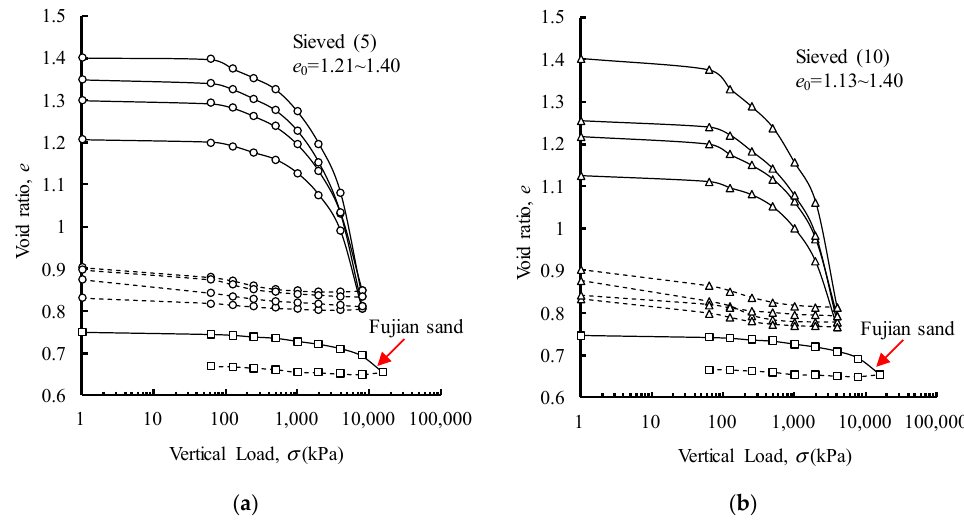
Figure 3. Compression curves of mixtures: ( a ) Rubber content = 5%; ( b ) rubber content = 10%.